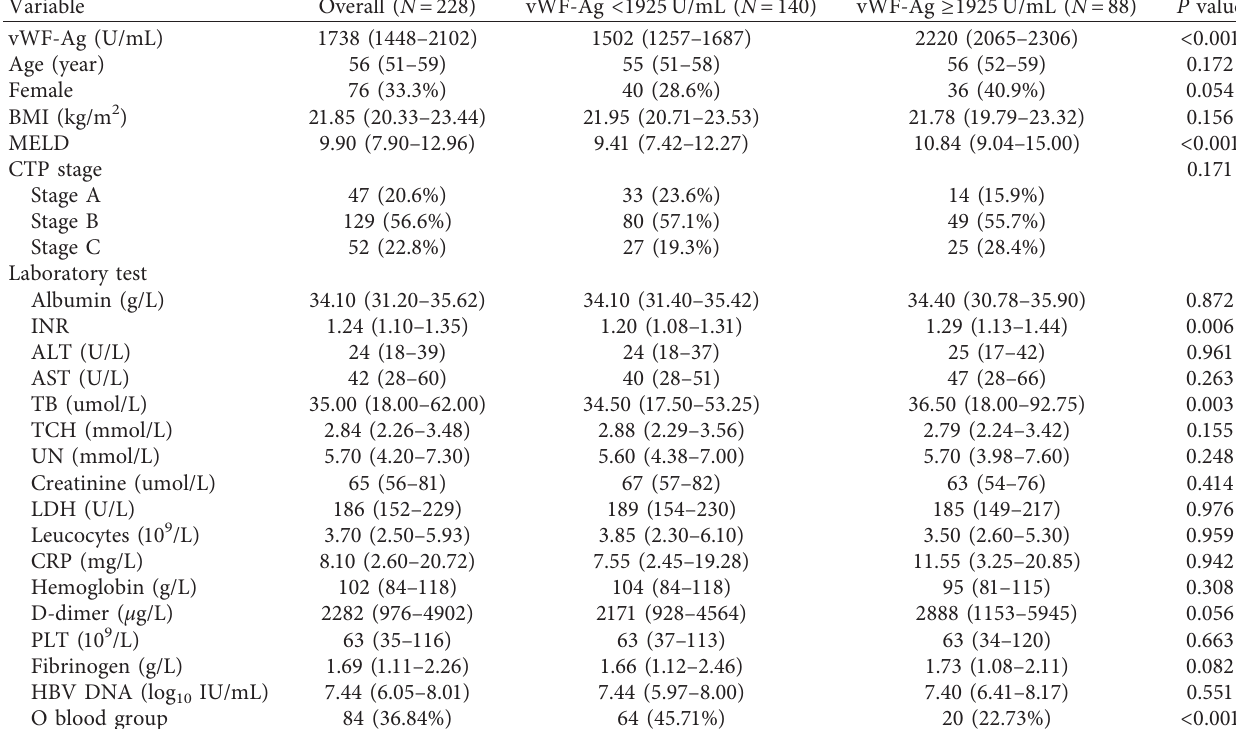
Table 1: Clinical characteristics of patients at the time of